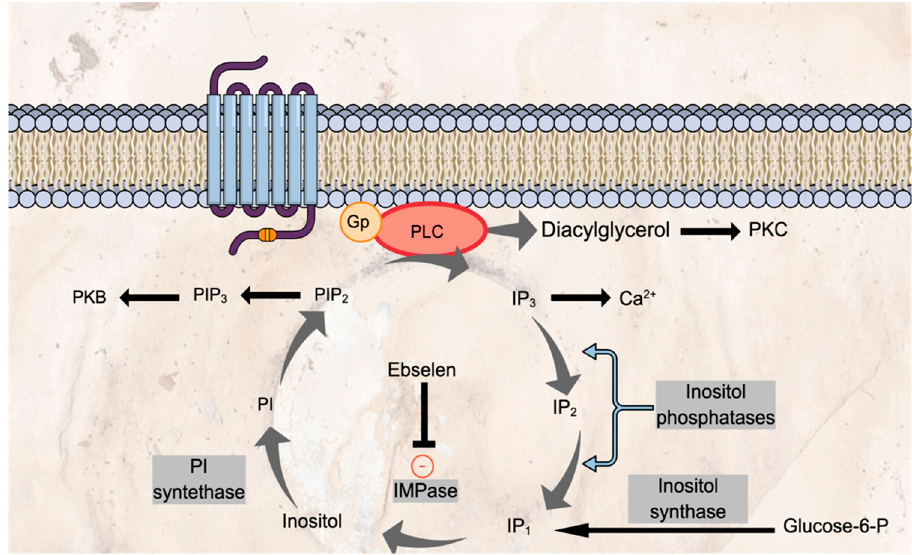
Figure 2. Phosphoinositide recycling and the effect of ebselen on IMPase. Glucose-6-P: glucose-6- phosphate; Gp: G-protein; IP 1 : inositol (1) phosphate; IP 2 : inositol bisphosphate; IP 3 : inositol (1,4,5) triphosphate; PI: phosphoinositol; PKB: protein kinase B; PKC: protein kinase C; PLC: phospholipase C; PIP 2 : phosphatidylinositol bisphosphate; PIP 3 : phosphatidylinositol trisphosphate. Singh, et al. [46] showed that intraperitoneal administration of ebselen in mice low- ered brain inositol levels one hour later. In humans, inositol levels in discrete brain regions can be measured in vivo using proton magnetic resonance spectroscopy (MRS). Two